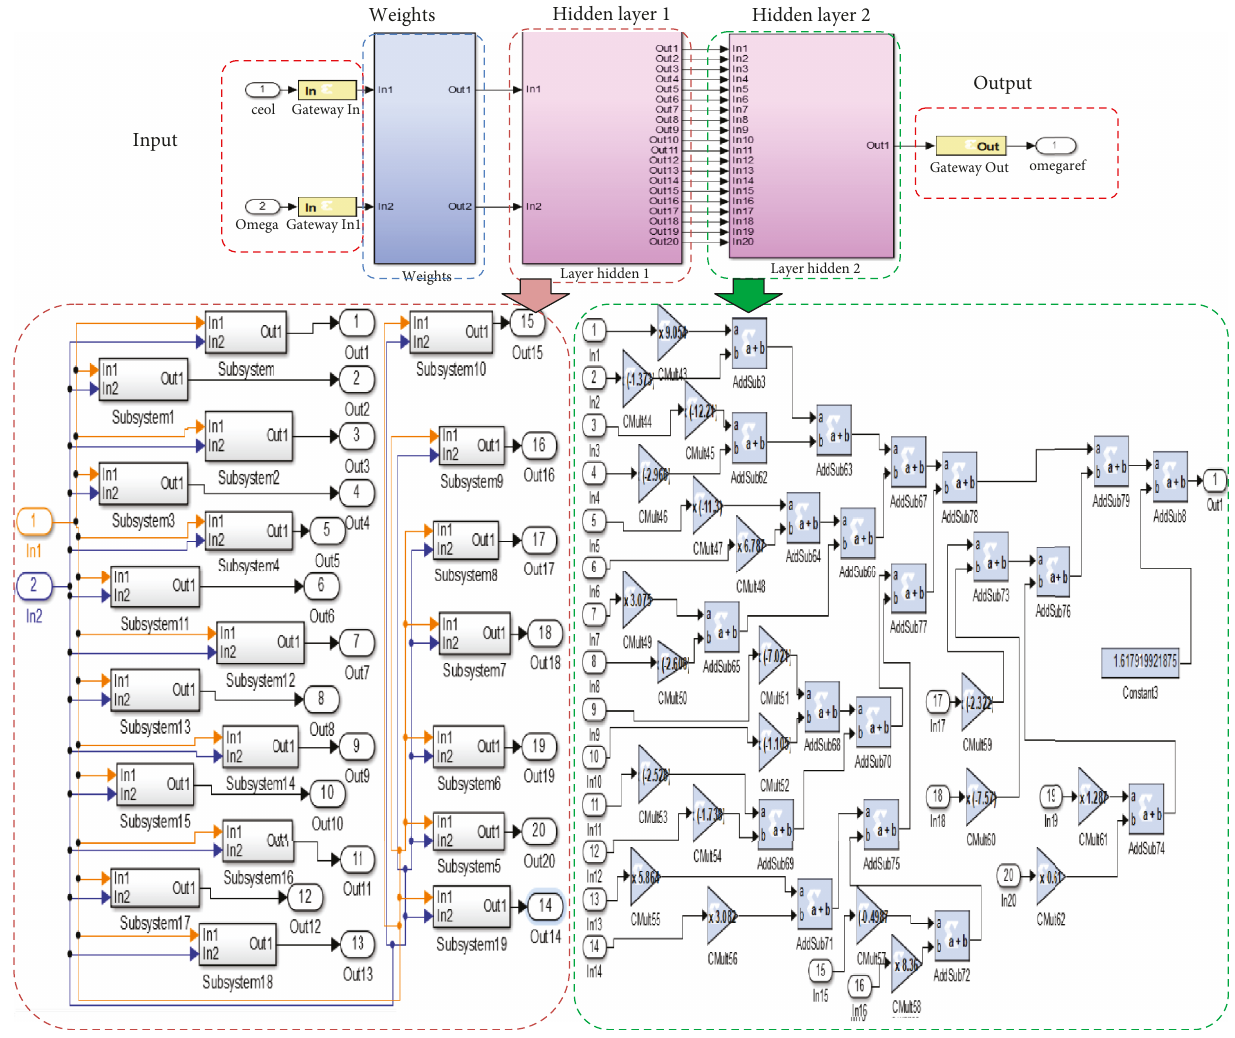
Figure 12: Neural network controller for the wind system on